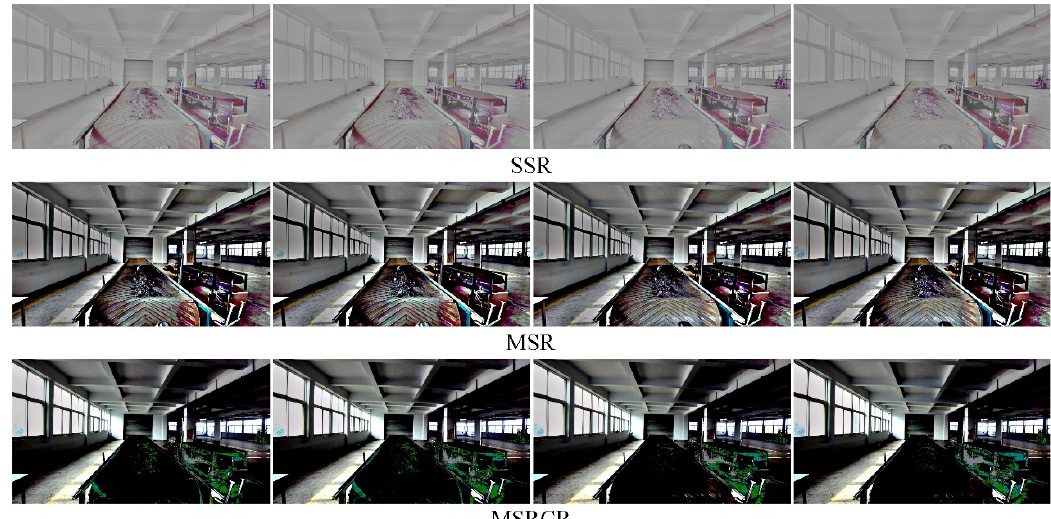
Figure 20. Enhancement of daytime backlight images by traditional algorithms.